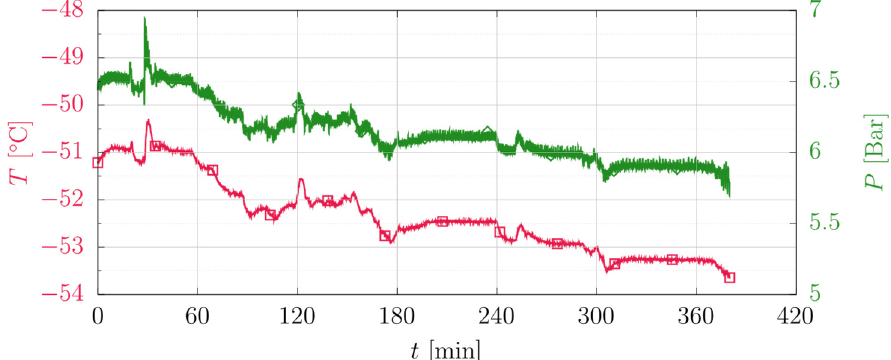
Figure 2. Pressure and liquid temperature in SV02 during the controlled stepwise reduction in pressure in Experiment 1 from 6.5 bar to 5.9 bar.